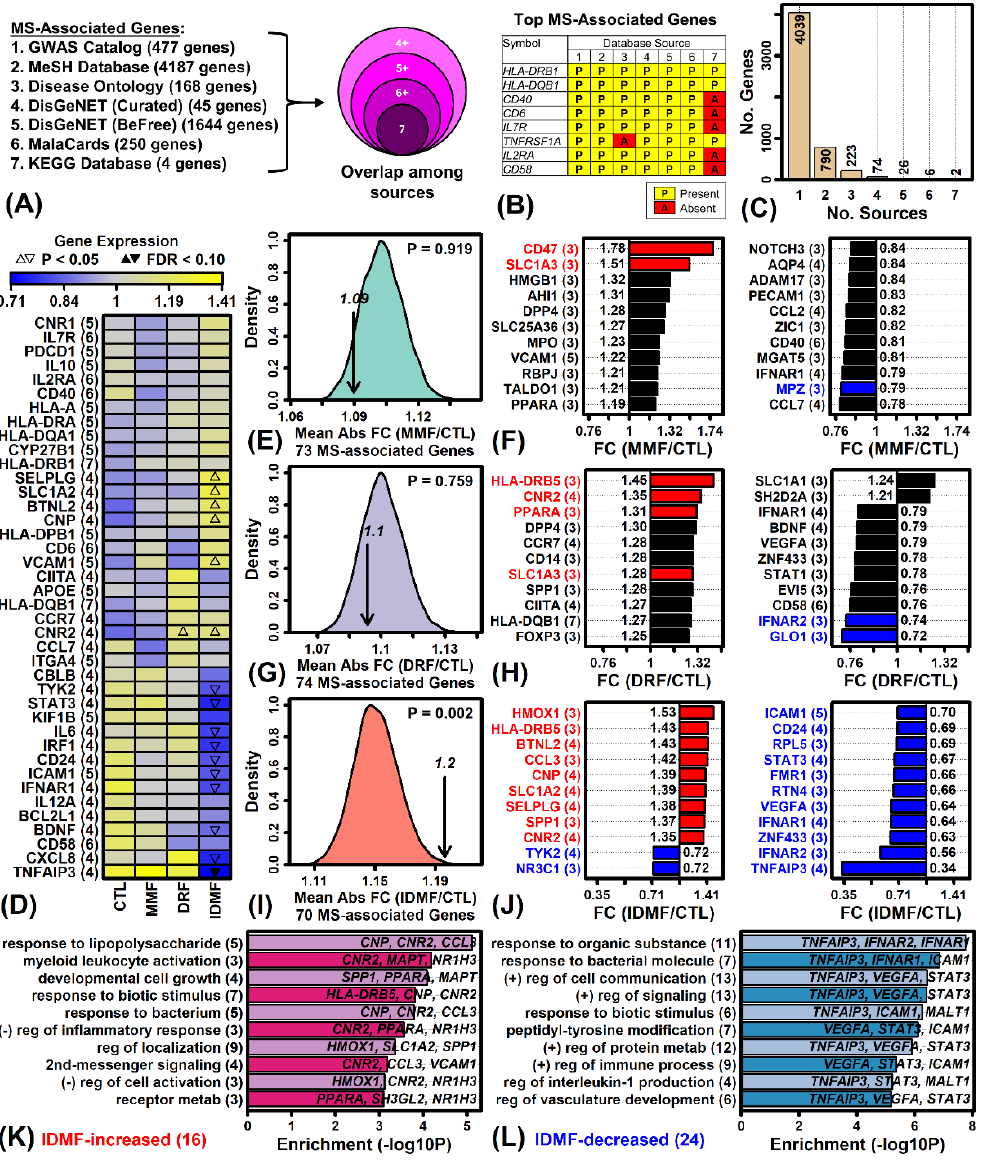
Figure 6. MS-associated genes. ( A ) MS gene databases. ( B ) Top MS-associated genes (six or more database sources). ( C ) Number of sources for MS-associated genes. ( D ) MS-associated genes (four or more sources) and their response to MMF, DRF, and IDMF. The 40 genes most strongly altered by one of the three compounds are shown (i.e., lowest p -value). ( E , G , I ) Average absolute FC (|log 2 (FC)|) of MS-associated genes (four or more sources). The null distribution shown was obtained by calculating the absolute FC in randomly sampled gene sets of the same size (10,000 simulation trials). ( F , H , J ) MS-associated genes most strongly altered by each compound (four or more sources). The number of database sources linking each to MS is shown in parentheses. Significantly altered genes ( p < 0.05) are shown in red (increased) or blue (decreased) font. ( K , L ) GO BP terms enriched among MS-associated genes (three or more sources) altered by IDMF ( p < 0.05 with FC > 1.25 or FC < 0.80). The number of genes associated with each GO BP term is indicated in parentheses (left margin) and example genes are listed within each